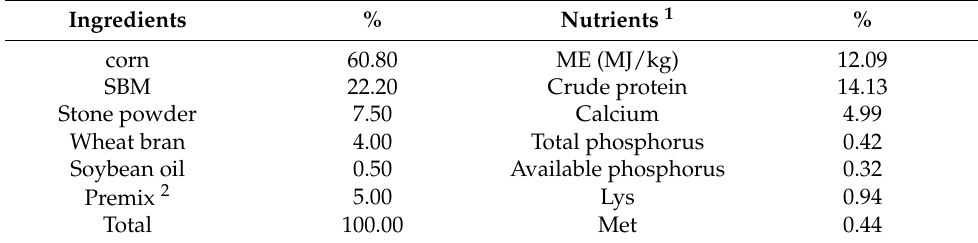
Table 1. Composition and nutrient levels of the basic diet (air-dry basis,